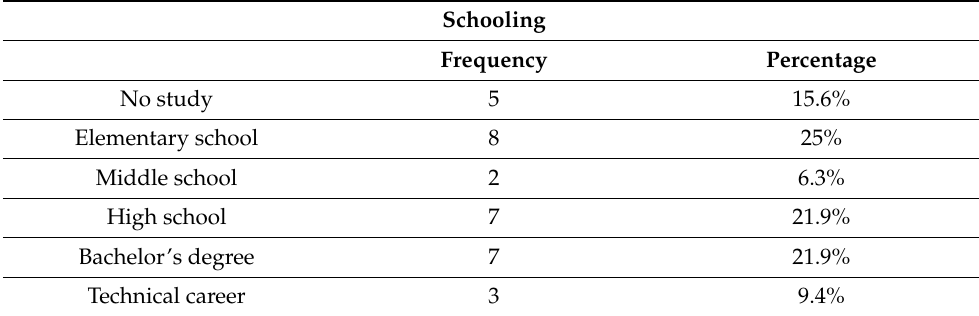
Table 1. Tutor’s Schooling Level and